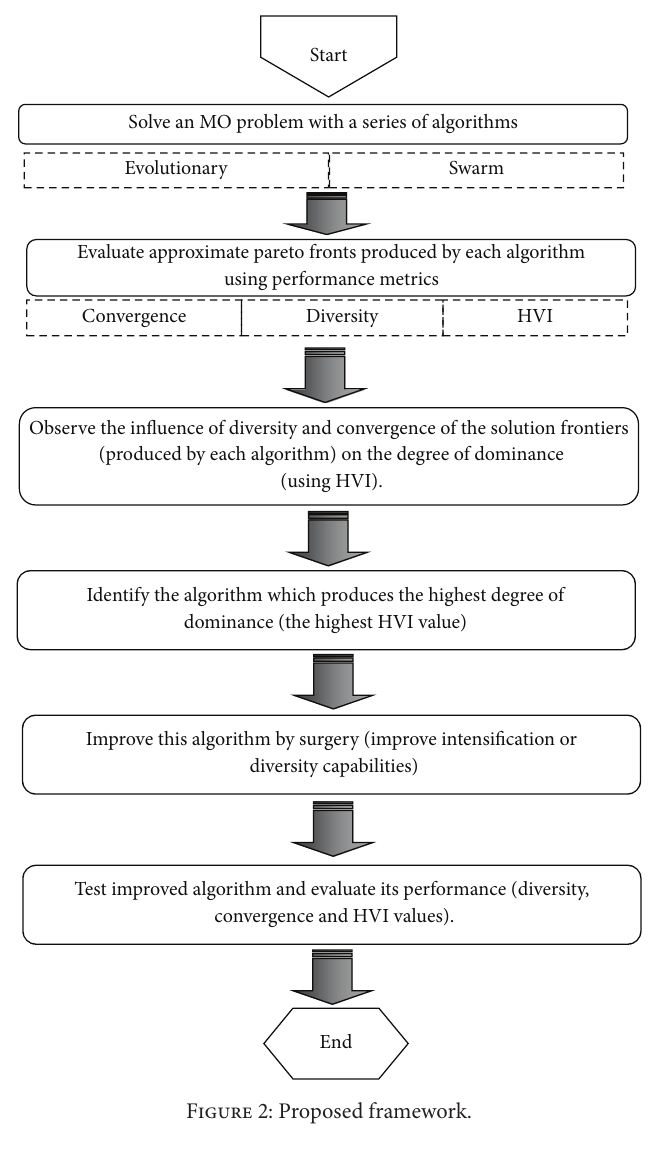
Figure 2: Proposed